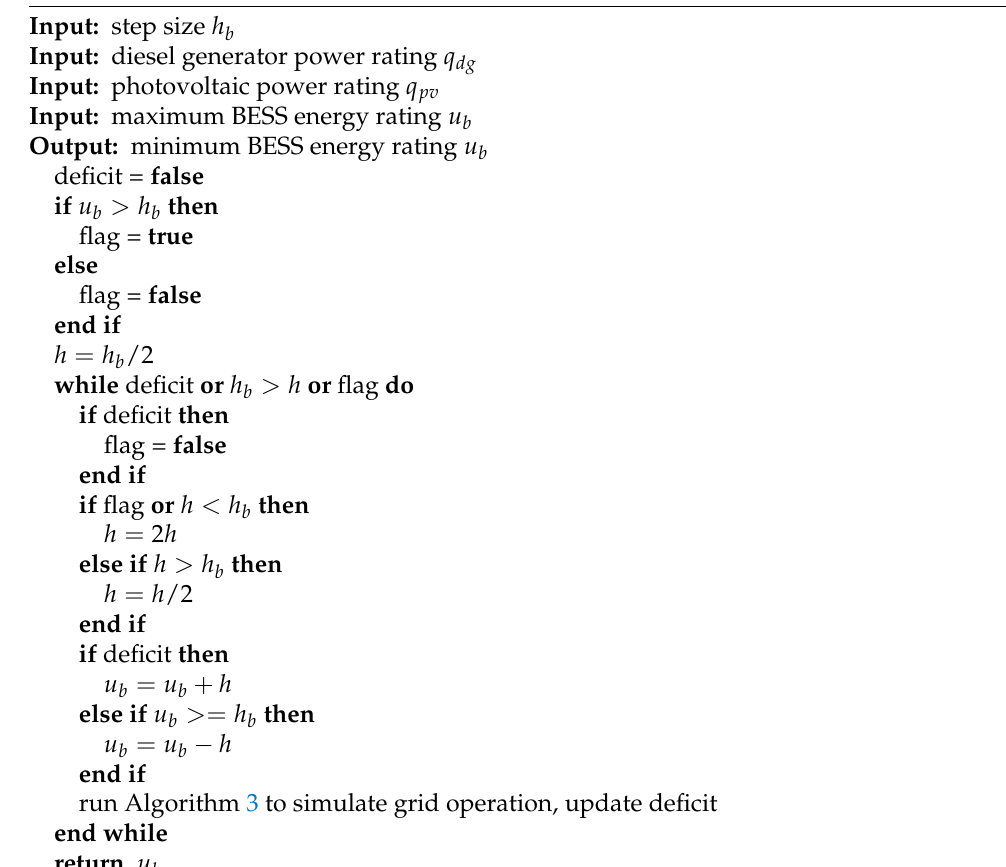
Algorithm 5 Minimum BESS energy rating to meet